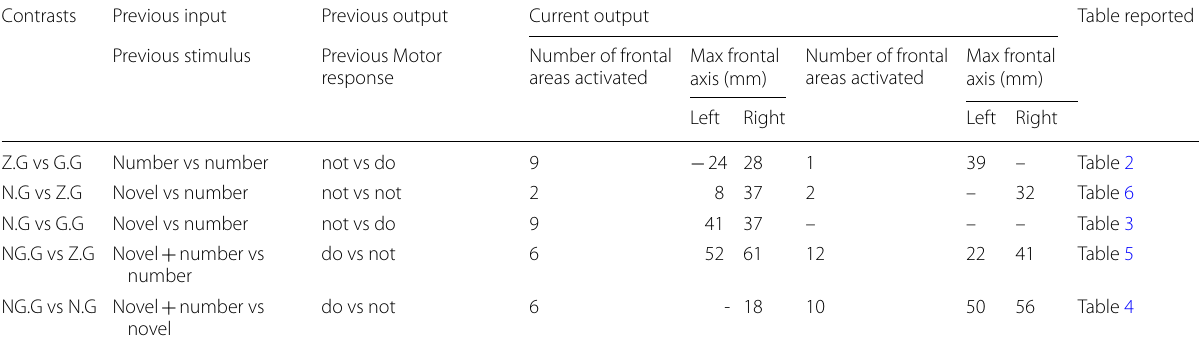
Table 7 Input/Output comparison of the number of Brain areas for the different contrasts explored Contrasts